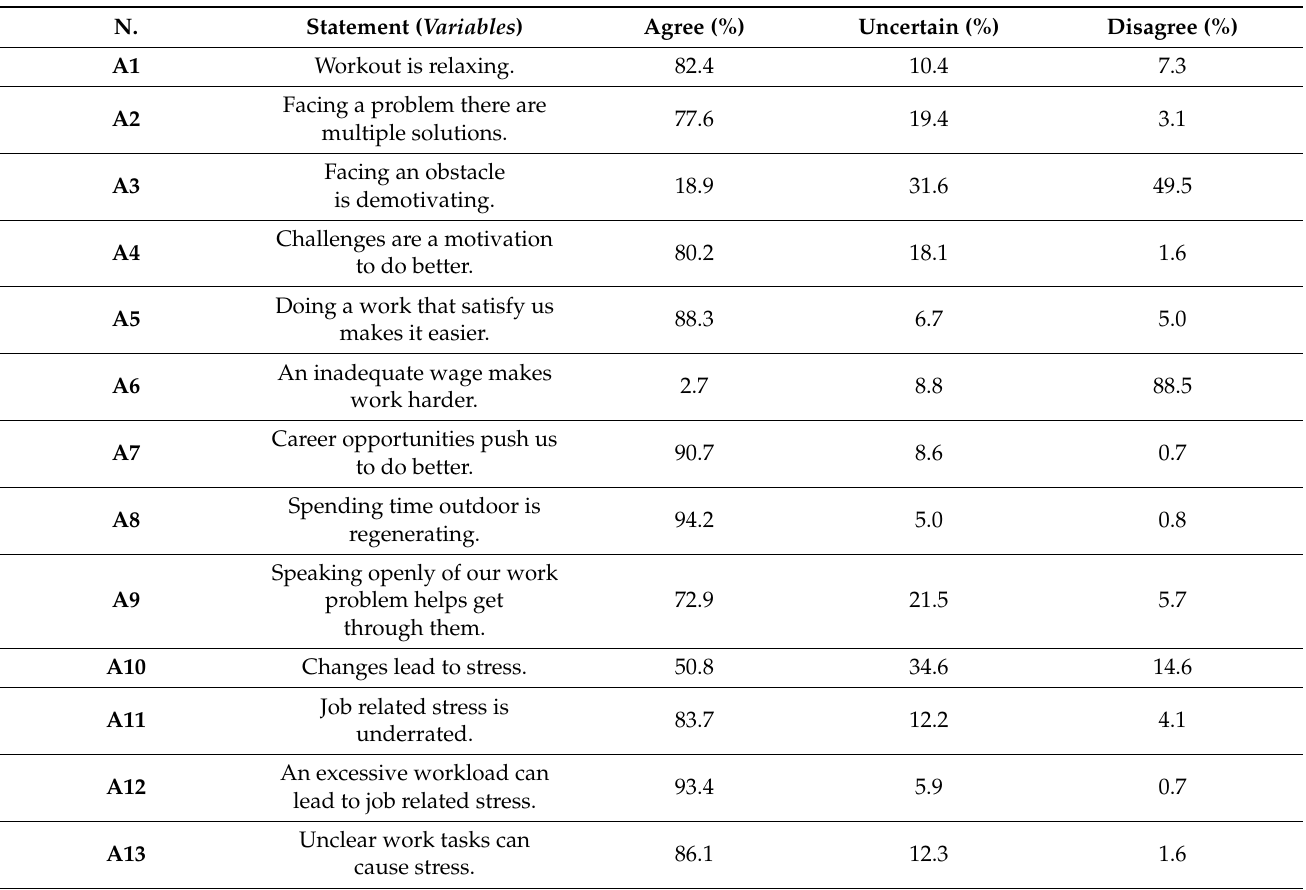
Table 3. Attitude of respondents toward job